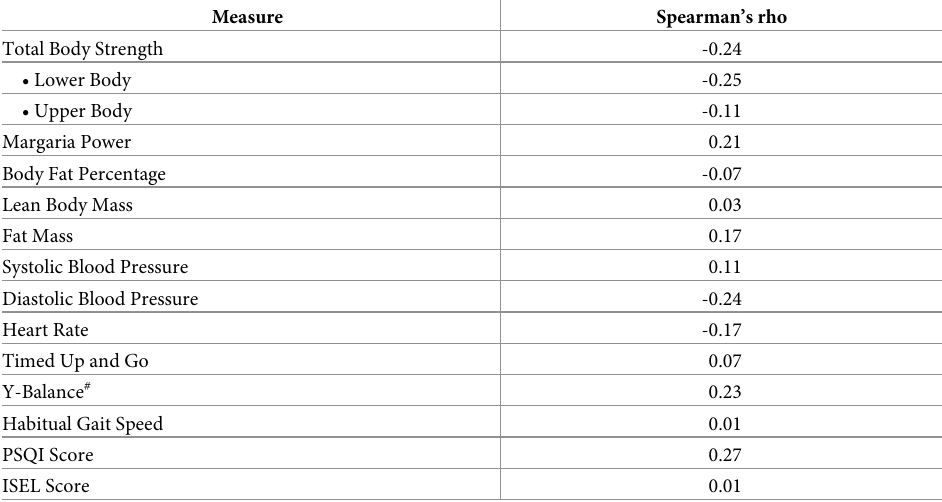
Table 5. Spearman’s rho correlations between pre- to post-intervention changes in fluid composite score and changes in other outcome variables of interest (N = 20). Measure Spearman’s rho